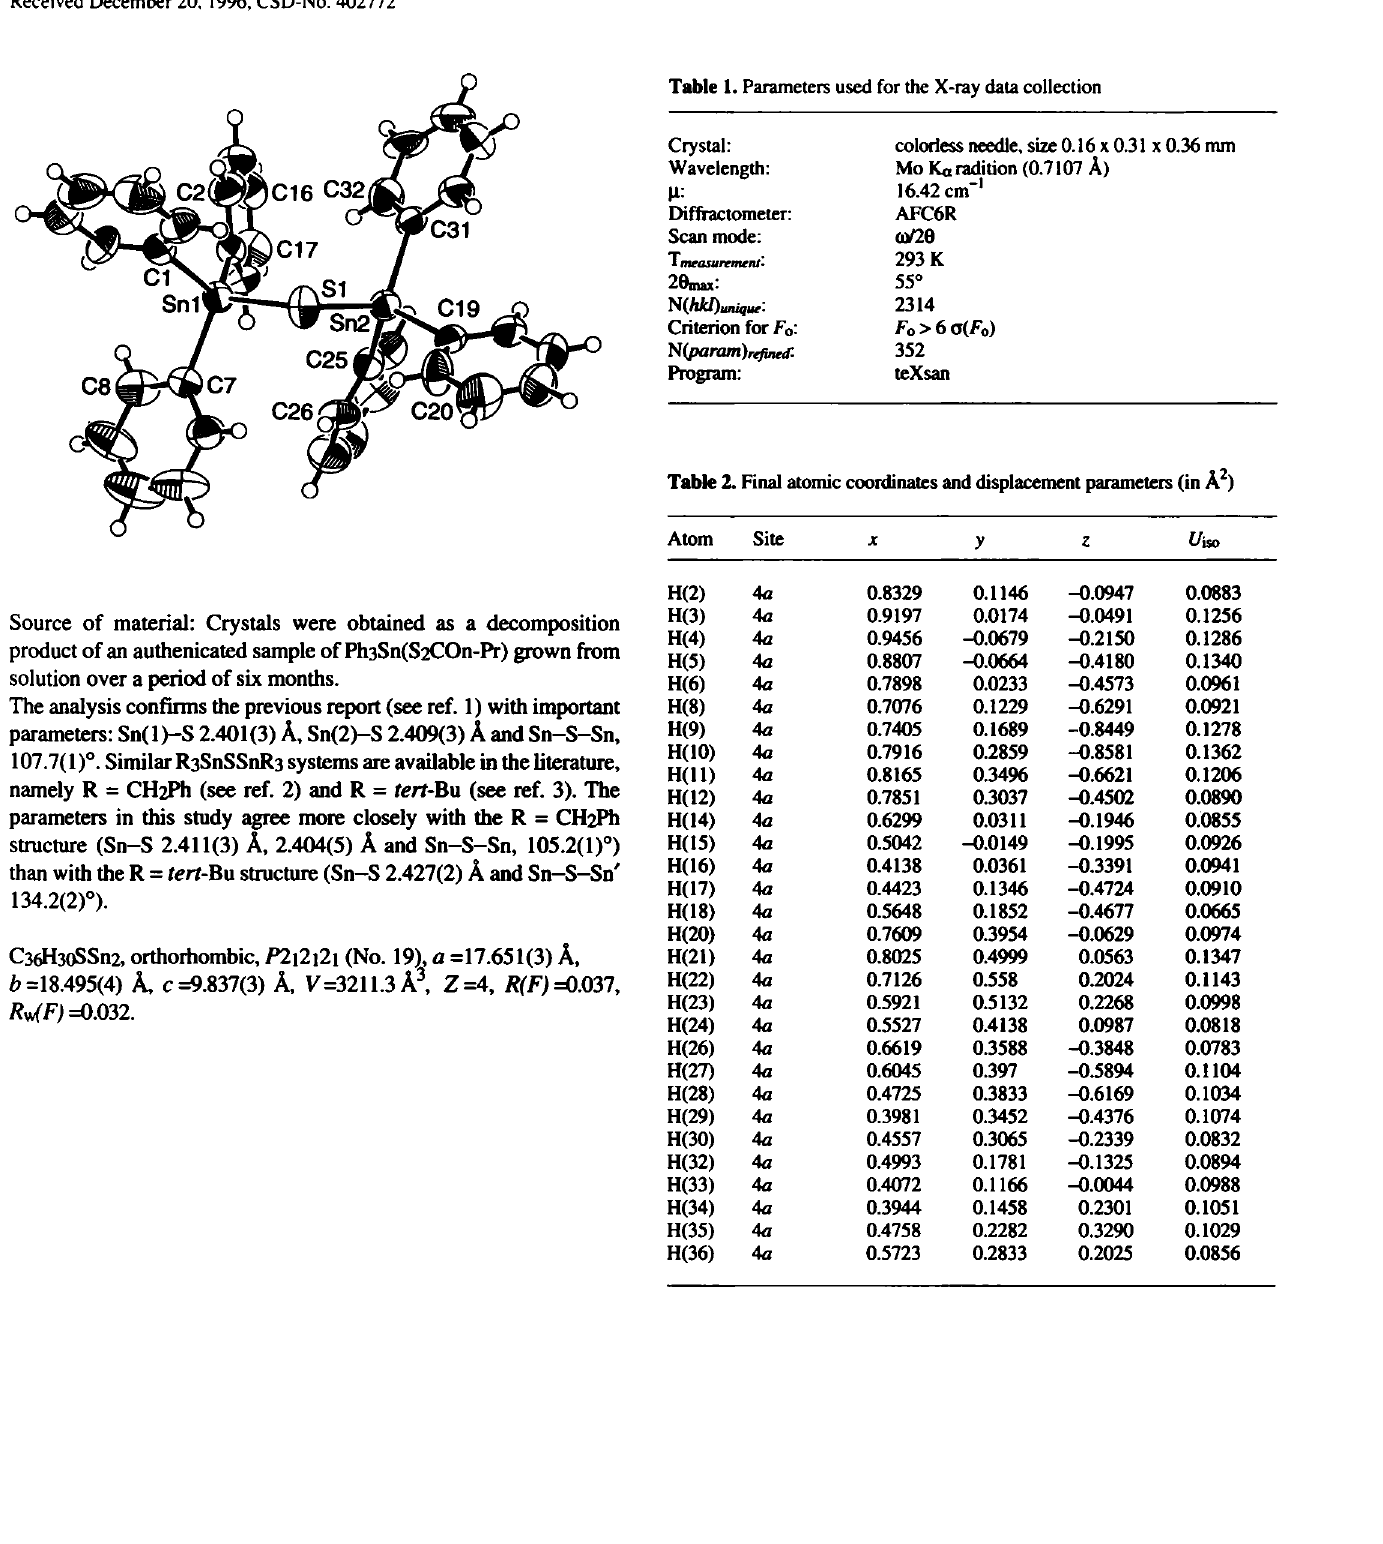
Table 1. Parameters used for the X-ray data collection Crystal: